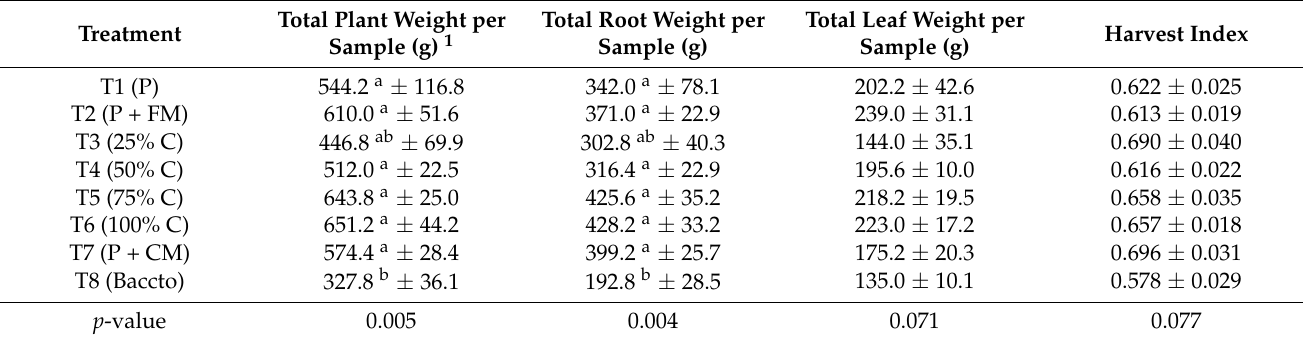
Table 6. Effect of different potting media treatments on beet yields 55 days after transplanting, or 114 days following seeding ( n = 5).